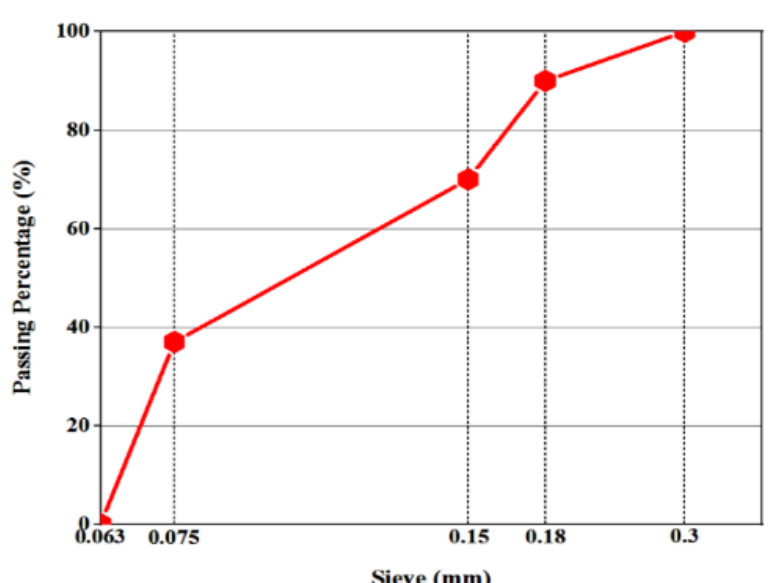
Figure 2. Crumb rubber powder.